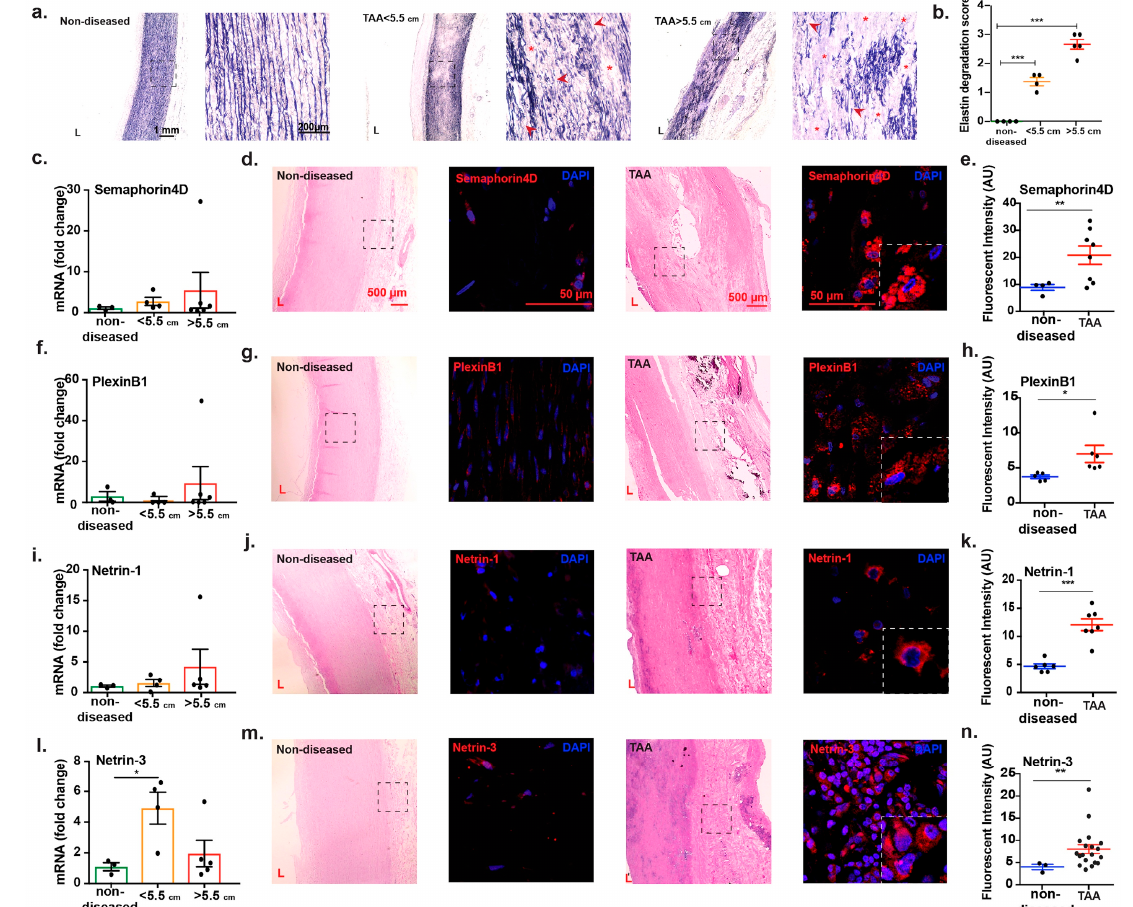
Figure 3. Transcript analysis and immunohistochemistry of Semaphorins and Netrins. ( a , b ) Elastin staining (Verhoeff-Van Gieson) and degradation score in non-diseased and TAA sections of size as indicated. Dashed boxes indicate magnified areas. Scale bars represent 1000 µm and 200 µm in low and high magnified images. Arrow indicate broken elastin fragments and stars indicate areas of complete elastin degradation. *** p < 0.001. Non-diseased ( n = 4), TAA < 5.5 cm ( n = 4), TAA > 5.5 cm ( n = 5) ( c ) Quantitative PCR analysis of Semaphorin4D transcripts in non-diseased ( n = 3), TAA < 5.5 cm ( n = 4), TAA > 5.5 cm ( n = 6). ( d ) Hematoxylin and Eosin (H & E) image and representative immunofluorescence staining of Semaphorin4D (red) and Dapi (blue) in non-diseased and TAA sections of human aorta. Dashed boxes indicate magnified areas of immunofluorescence staining ( e ) Quantification of Semaphorin4D immunofluorescence staining in non-diseased and TAA. ( f ) Quantitative PCR analysis of PlexinB1 transcripts in non-diseased ( n = 3), TAA < 5.5 cm ( n = 4), TAA > 5.5 cm ( n = 6). ( g ) H & E image and representative fluorescence staining of PlexinB1 (red) and Dapi (blue) in non-diseased and TAA. ( h ) Quantification of PlexinB1 immunofluorescence staining in non-diseased and TAA. ( i ) Quantitative PCR analysis of Netrin-1 transcripts in non-diseased ( n = 3), TAA < 5.5 cm ( n = 4), TAA > 5.5 cm ( n = 5). ( j ) H & E image and representative immunofluorescence staining of Netrin-1 (red) and Dapi (blue) in non-diseased and TAA sections of human aorta. Dashed boxes indicate magnified areas of immunofluorescence staining ( k ) Quantification of Netrin-1 immunofluorescence staining in non-diseased and TAA. ( l ) Quantitative PCR analysis of Netrin-3 transcripts in non-diseased ( n = 3), TAA < 5.5 cm ( n = 4), TAA > 5.5 cm ( n = 5). ( m ) H & E image and representative immunofluorescence staining of Netrin-3 (red) and Dapi (blue) in non-diseased and TAA sections of human aorta. Dashed boxes indicate magnified areas of immunofluorescence staining. ( n ) Quantification of Netrin-3 immunofluorescence staining in non-diseased and TAA. * p < 0.05 ** p < 0.01 *** p <0.001. L = lumen. Scale bars represent 500 µm on H & E images. Magnified scale bars are 50 µm.